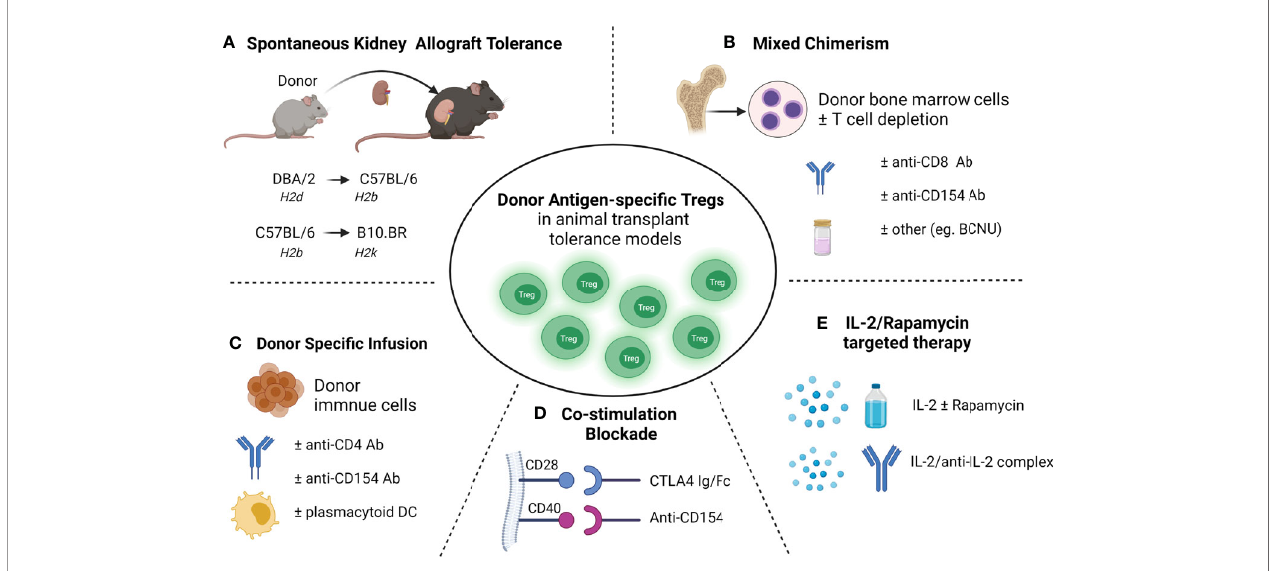
FIGURE 1 | Donor antigen-speci fi c Tregs developed in transplant tolerance mouse models (A) Spontaneous acceptance of kidney allotransplant tolerance. (B) Mixed chimerism induced allo-transplantation tolerance via bone marrow transplantation. (C) Donor-speci fi c transfusions (DST) induced allotransplantation tolerance. (D) Blockade of the B7-CD28 (using CTLA-4 Ig/Fc) or/and CD40-CD40L (using anti-CD154 mAb) co-stimulatory pathway induced transplantation tolerance; (E) and IL-2 and rapamycin targeted therapies induced transplantation